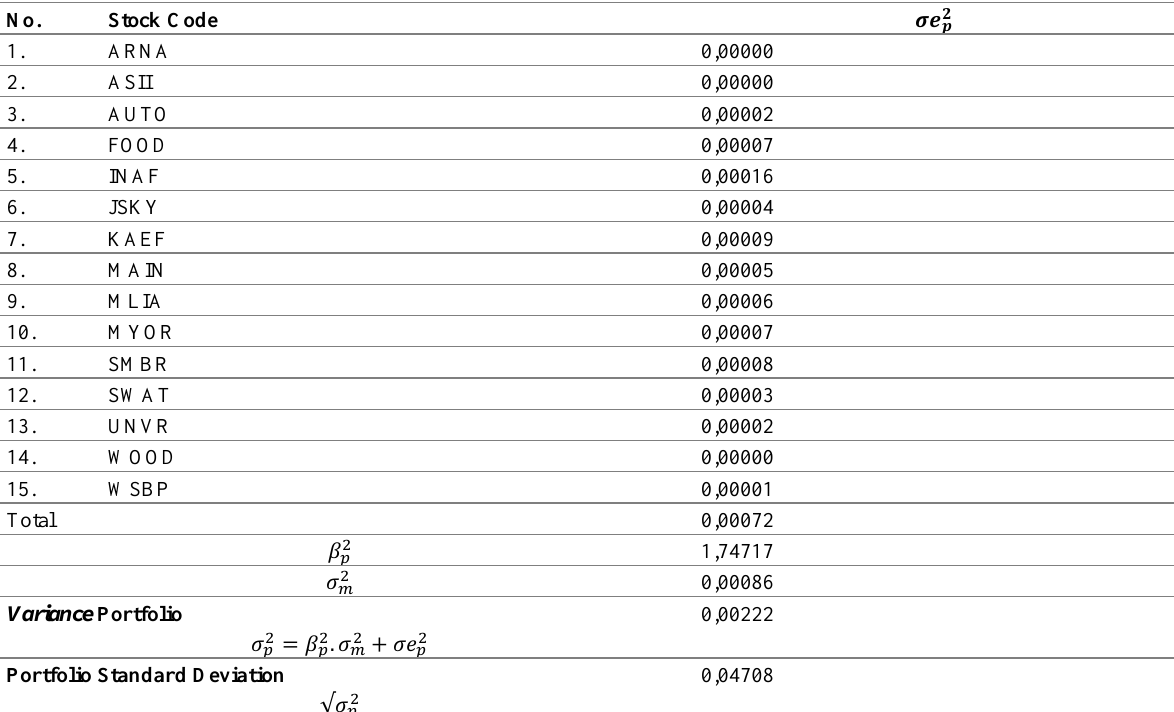
Table 7: Optimal Portfolio